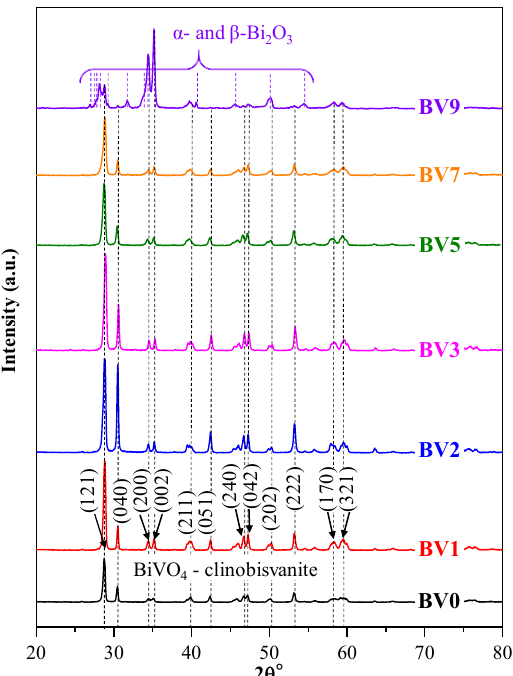
Figure 1. The XRD patterns of the as-obtained photocatalysts, showing the presence of the monoclinic crystal phase, the only exception being sample BV9, where α- and β-Bi 2 O 3 were also detected.